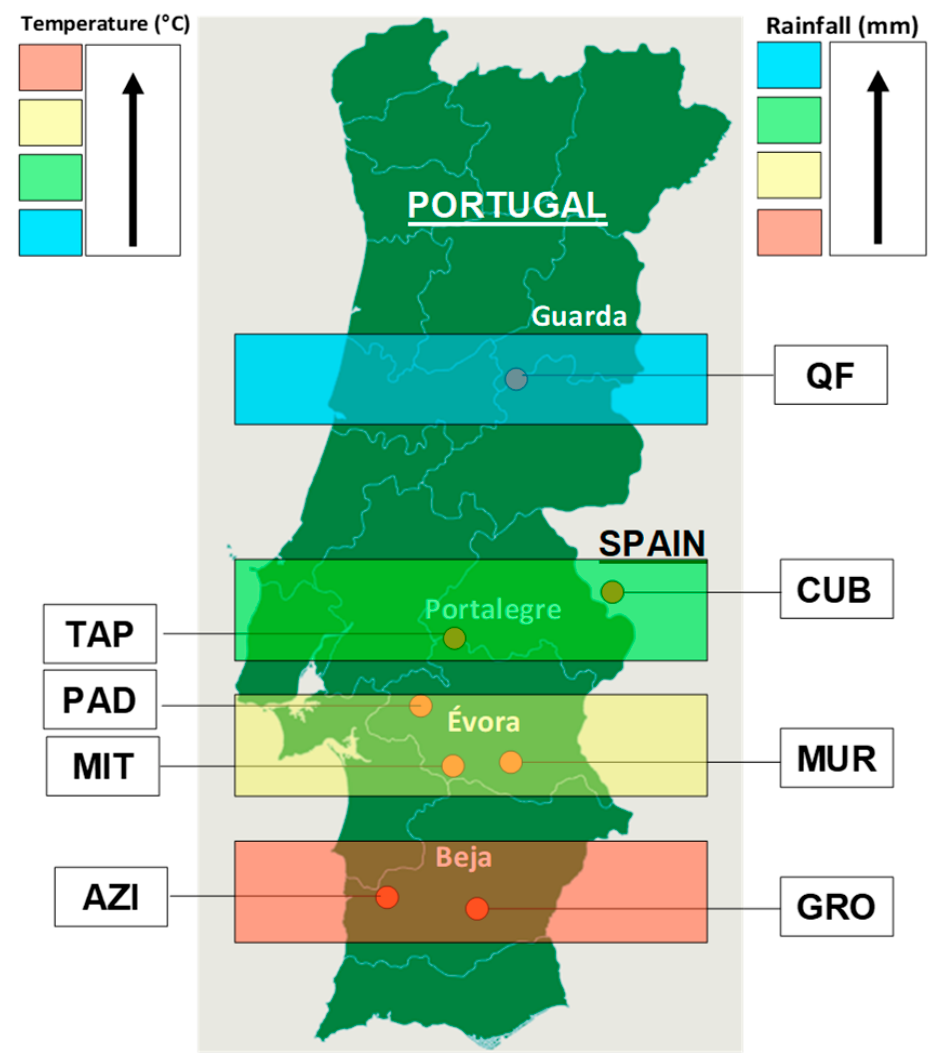
Figure 2. Location of experimental farms in Portugal.